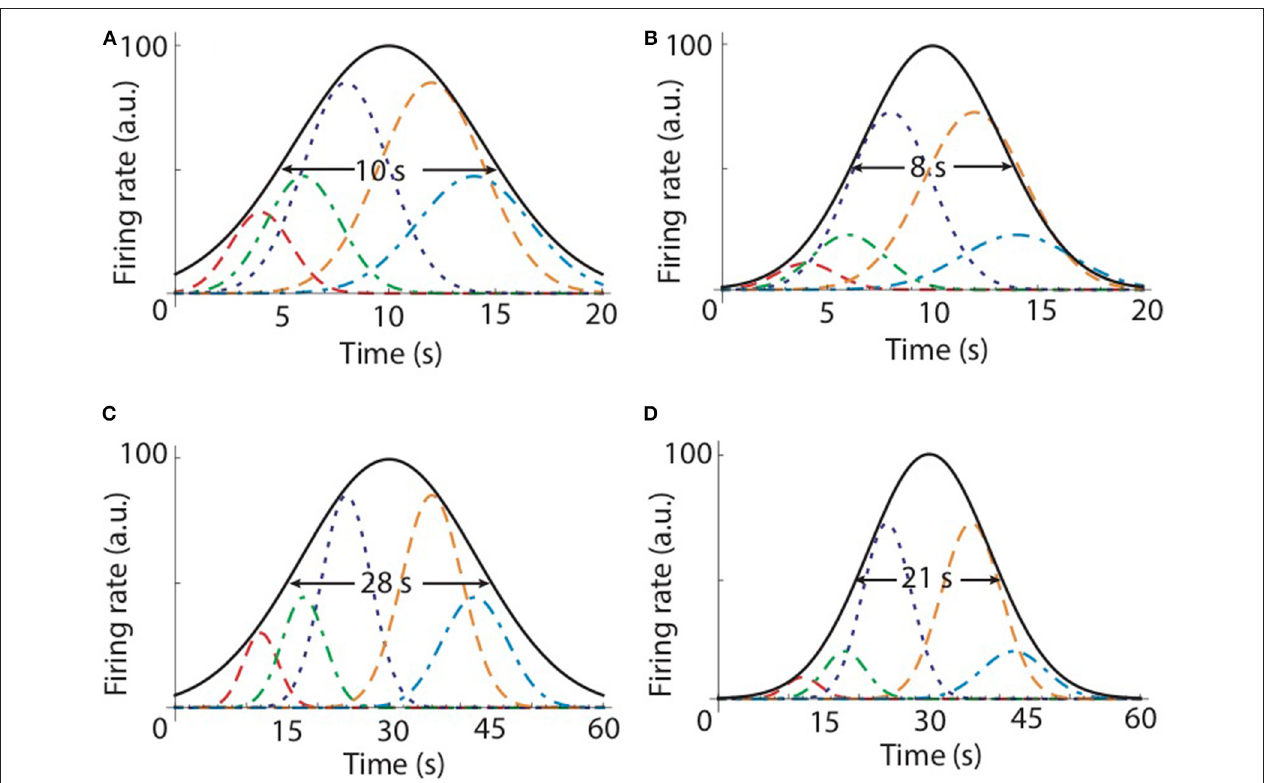
FIGURE 2 | A population of time cells could learn the temporal map for the hippocampus. (A) Firing rate curves for five representative time cells that peak at 4 s (red dashed line), 6 s (green dashed-dotted line), 8 s (blue dotted line), 12 s (orange dashed line), and 14 s (slate blue dashed-dotted line), respectively. Starting from an initially uniform distribution of weights, the first learning trial adjusts the weights to 0.15, 0.22, 0.4, 0.4, and 0.22, respectively. (B) Based on Equation (3), the second trial further adjusted the weights to 0.02, 0.05, 0.16, 0.16, and 0.05, respectively. The envelope of the population of time cells (black continuous line) shows that the peak is around the to-be-learned criterion time T 10s and the envelope becomes narrower as the number of trials increases. (C) For the criterion time of T 30s, = = only some representative firing rate curves are shown for 12 s (red dashed line),18 s (green dashed-dotted line), 24 s (blue dotted line), 36 s (orange dashed line), and 42 s (slate blue dashed-dotted line), respectively. The envelope of the population (black continuous line) peaks at T 30s. (D) The envelope for the second trial is = narrower and its width for a criterion time T 30s (C,D) is approximately three times larger compared to width for T 10s (A,B) = =